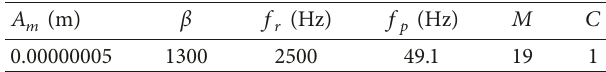
Figure 8: IRSs with different impulse lengths P : (a) P � 8; (b) P � 16; (c) P � 32; (d) P � 64. Table 3: Simulation parameters for Case